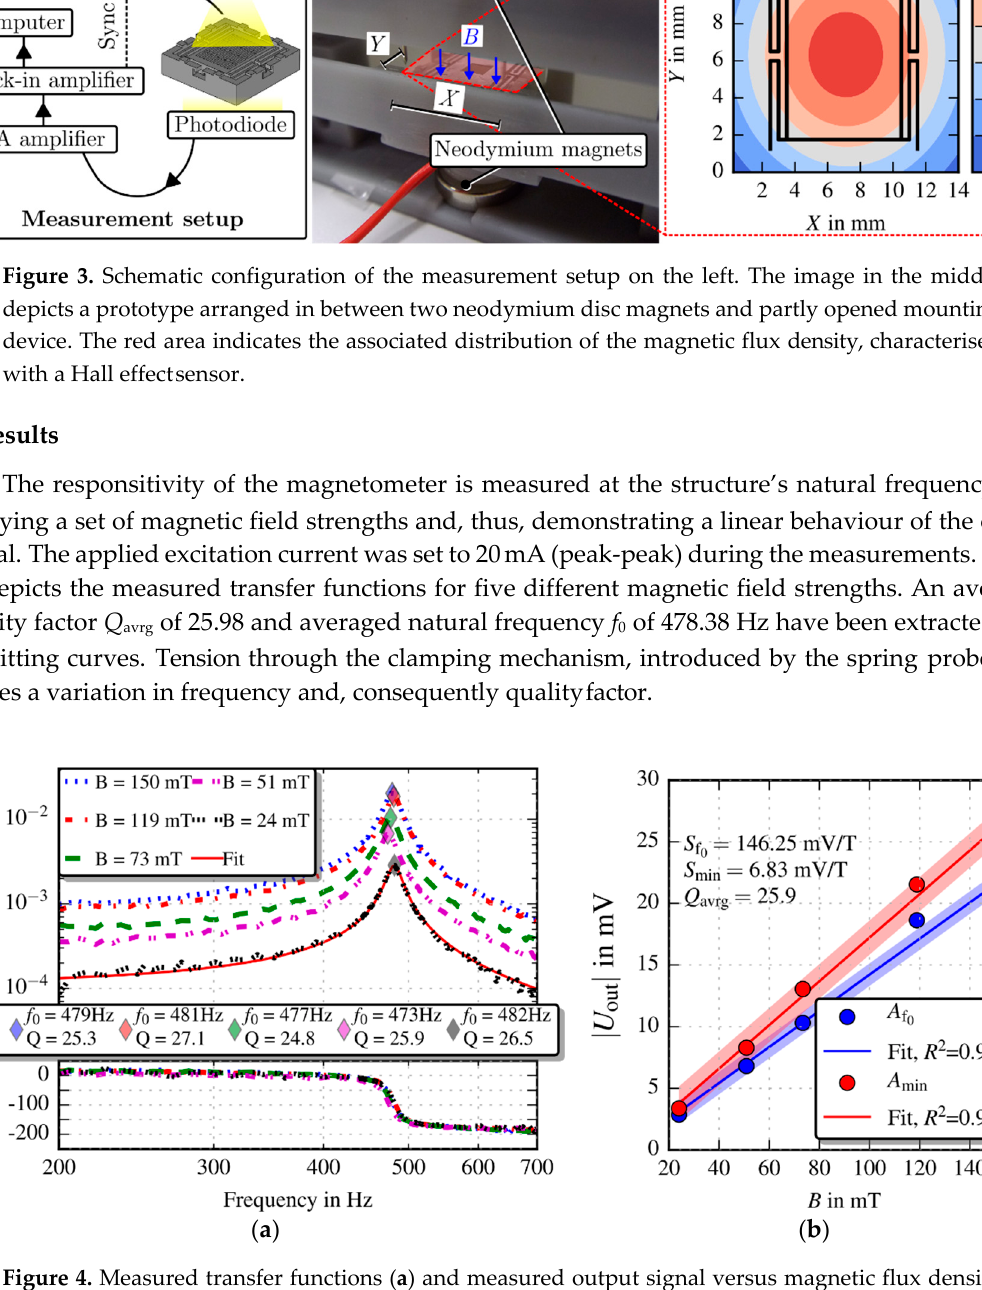
Figure 4. Measured transfer functions ( a ) and measured output signal versus magnetic flux density with linear fit ( b ). All data were fitted to extract the quality value Q via the − 3 dB bandwidth method and f 0 . A f 0 and A min are the measured values at the structure’s resonance frequency and at 200 Hz, respectively. A min was harmonised, hence multiplied with the averaged quality factor Q avrg , to allow comparison with the data at